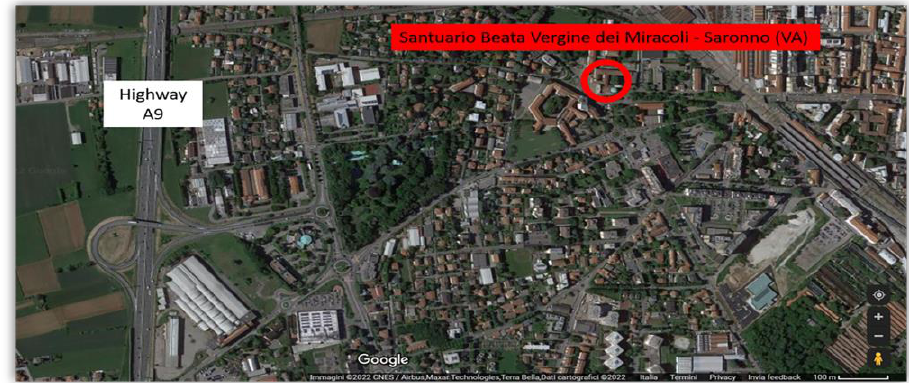
Figure 7. Location of the Sanctuary with respect to the A9 Highway.